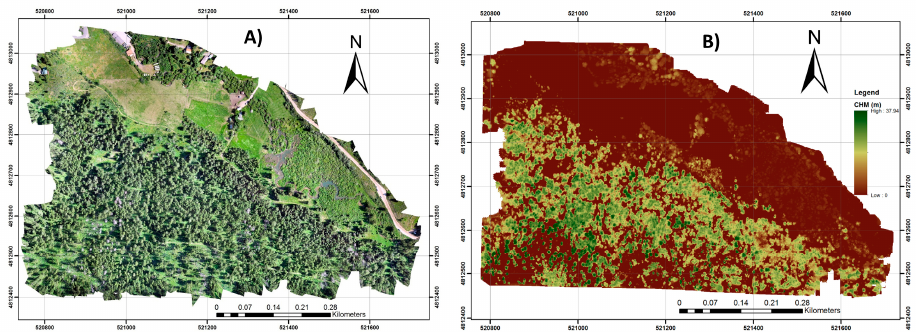
Figure 3. UAV-derived Orthomosaic ( A ) and Canopy Height Model ( B ).